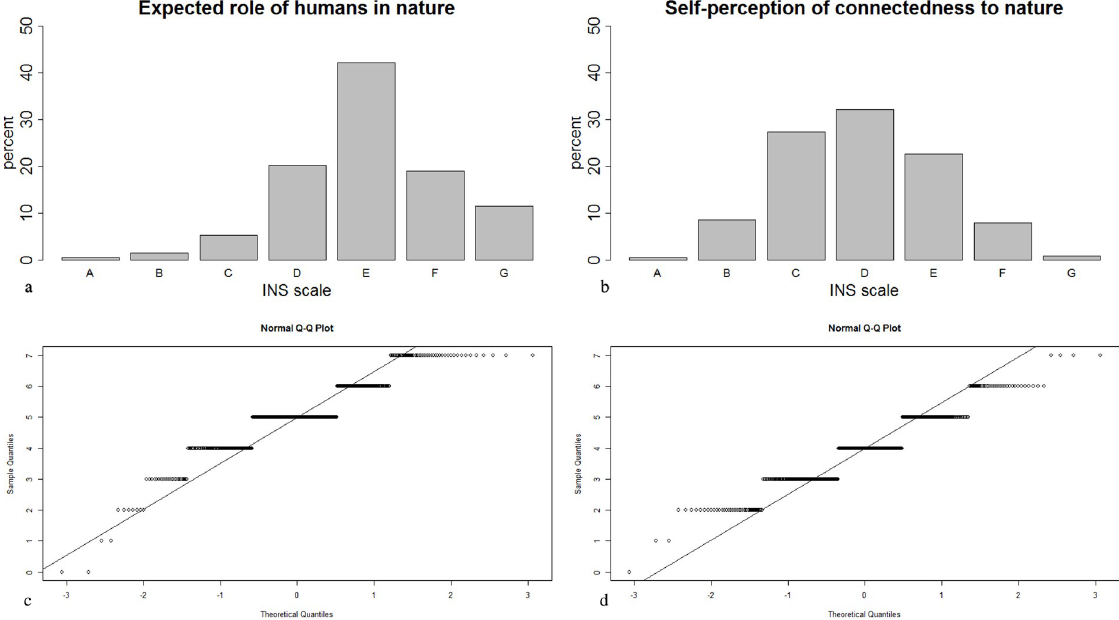
Fig 6. Connectedness to nature: ‘human-perception’ (a, c) and ‘self-perception’ (b, d) including Q-Q plot graphics showing normally distributed data based on the Likert